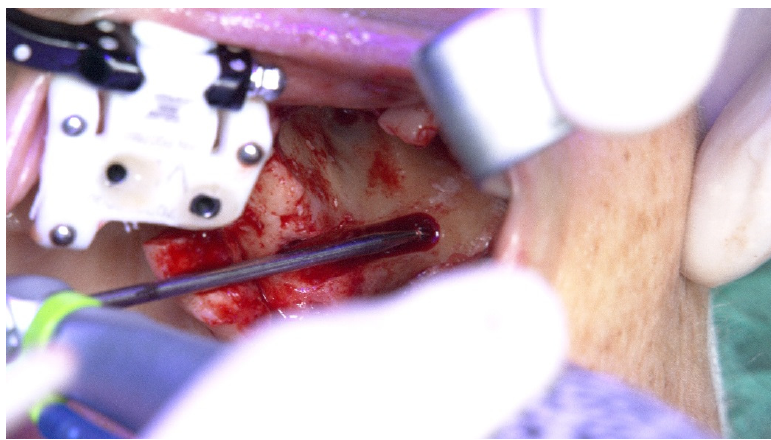
Figure 23. Perioperative photograph illustrating the use of the round bur for zygoma implant preparation.